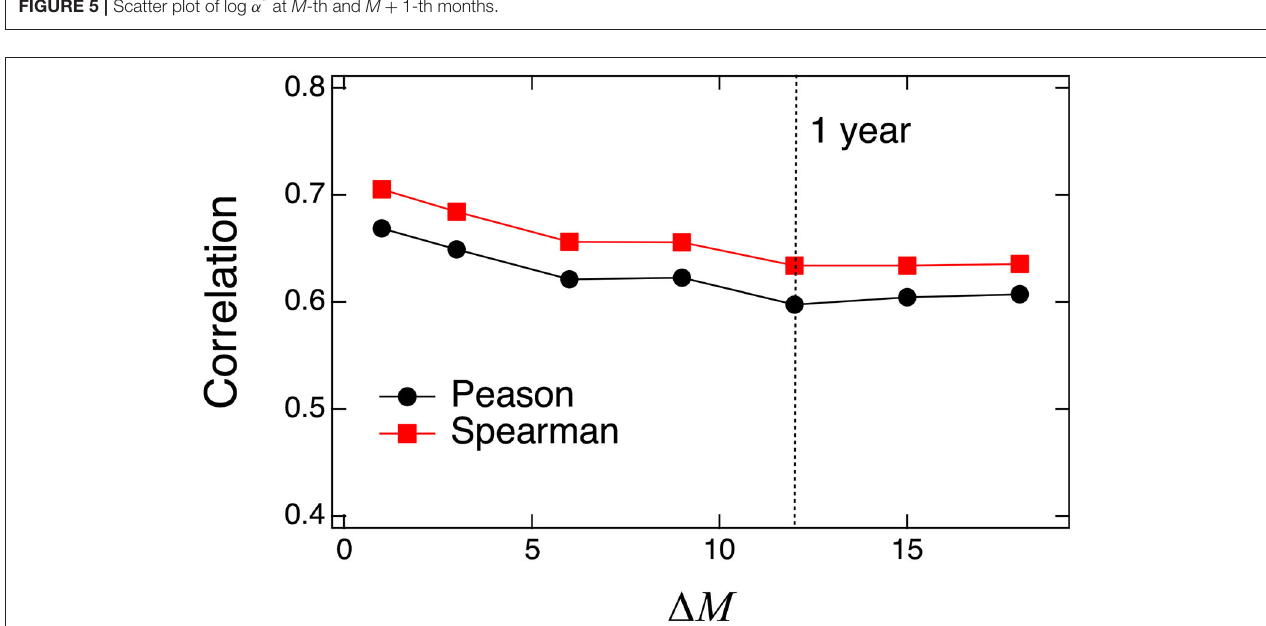
FIGURE 6 | Pearson product-moment correlation and Spearman rank-order correlation for log( α * i ) at M and 1 M months.